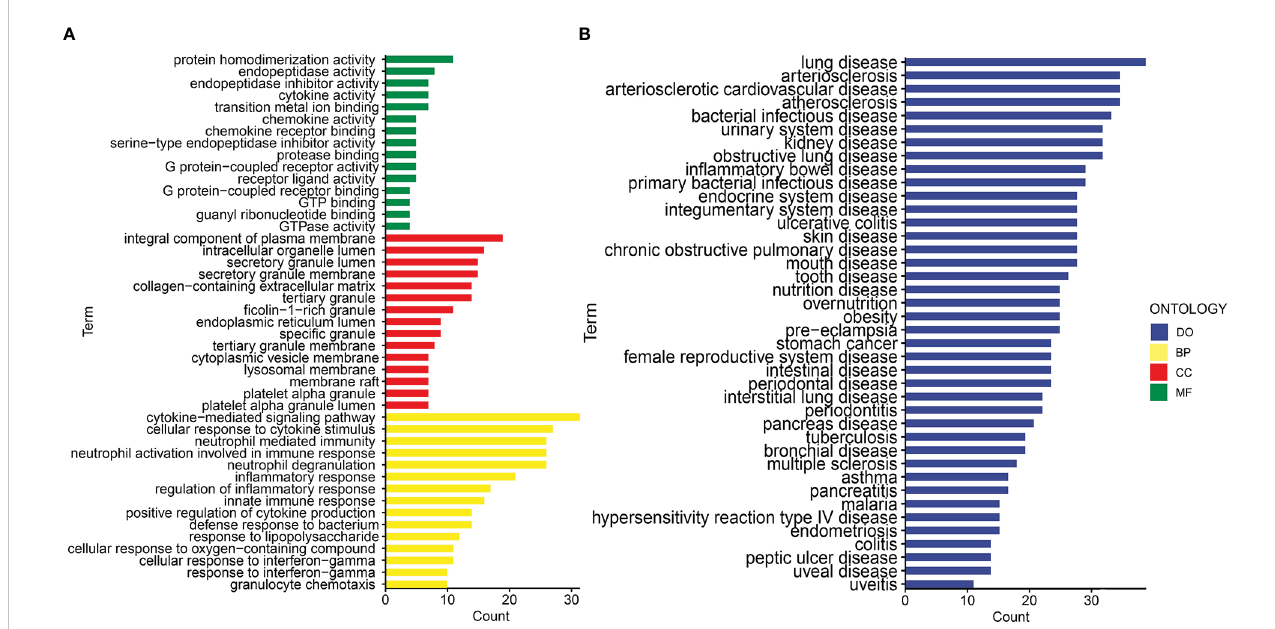
FIGURE 3 The bar graphs of the ontological enrichment analysis of the shared DEGs between COVID-19 and IBD. (A) Gene Ontology (GO) enrichment analysis of the shared DEGs. (B) Disease Ontology (DO) enrichment analysis of the shared DEGs.